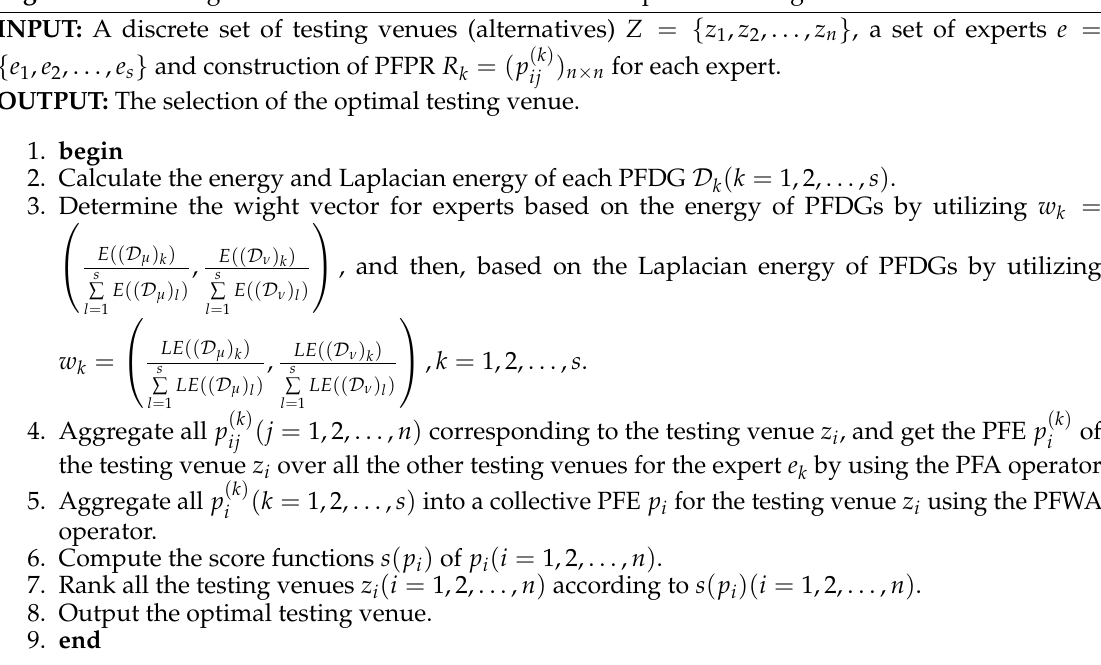
Algorithm 1 The algorithm for the selection of the most important testing